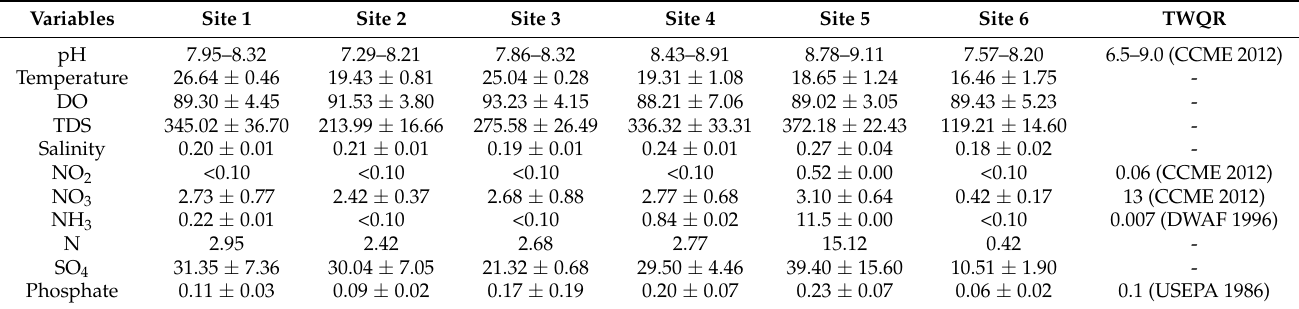
Table 2. Water quality variable levels recorded at six sites in the Palmiet River (mean ± standard deviation). SI units are in mg/L unless specified otherwise. The table also presents guidelines stipulated by DWAF (1996) and (CCME (2012) for the protection of aquatic